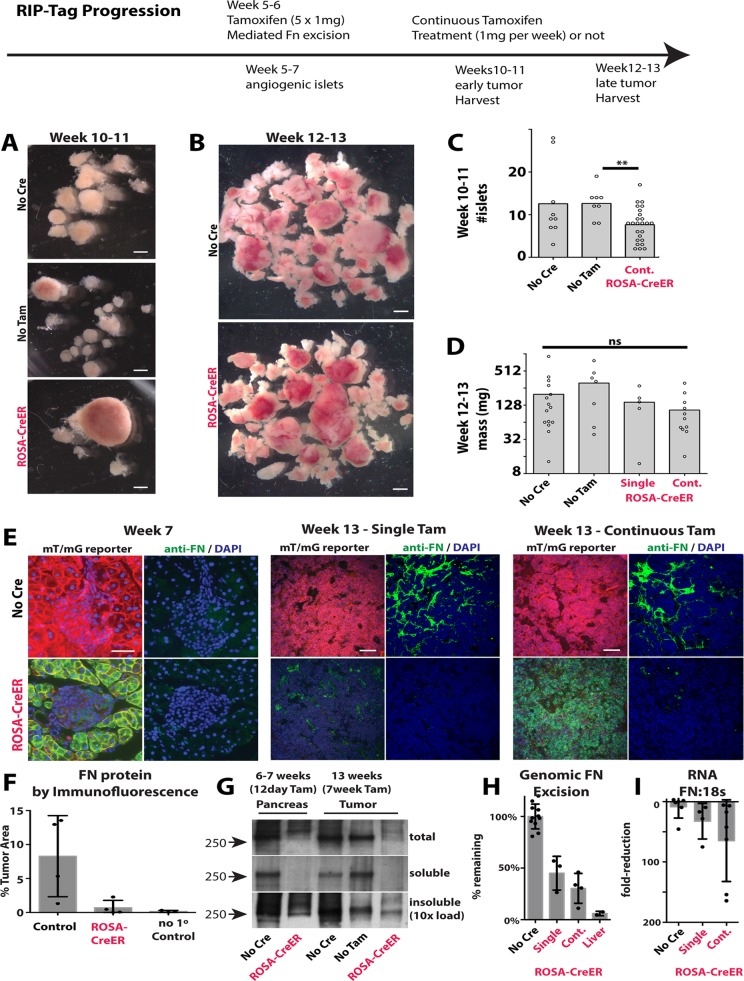
RIP-Tag Tumor growth in the absence of Fibronectin.(A&B) Isolated pancreatic tumors from individual mice. (C) Numbers of angiogenic islets isolated from individual mice. (D) Total mass of tumors isolated from individual mice. (E) Immunofluorescence staining for FN in the pancreas or in tumors in mT/mG reporter mice. (F) Percentage of the total tumor area covered by FN staining in individual mice. Each dot represents the average of three fields from a single mouse. Non-specific control represents the staining from pre-immune serum. (G) Western blot of equal tissue loads (by wet mass) of total pancreas or tumor, and 1% DOC-soluble and insoluble protein. (H) Remaining FN genomic DNA after Cre-mediated deletion, as determined by qPCR relative to an unaffected genomic location. (I) Fold-reduction in FN mRNA expression relative to 18s. Each point represents the results from the largest tumor in each mouse. Scale bars (A&B) = 1mm, (E) 7 week = 50μm, 13 week = 100μm. ** p value <0.01.